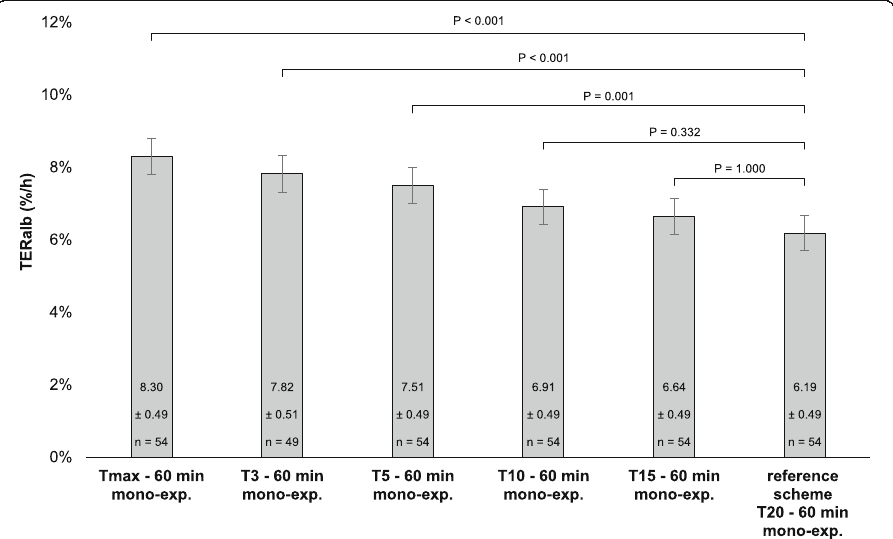
scheme. The mean TER values of the other time schemes were compared to the ref- alb based on mono-exponential kinetic analysis. erence scheme T 20 – 60 min